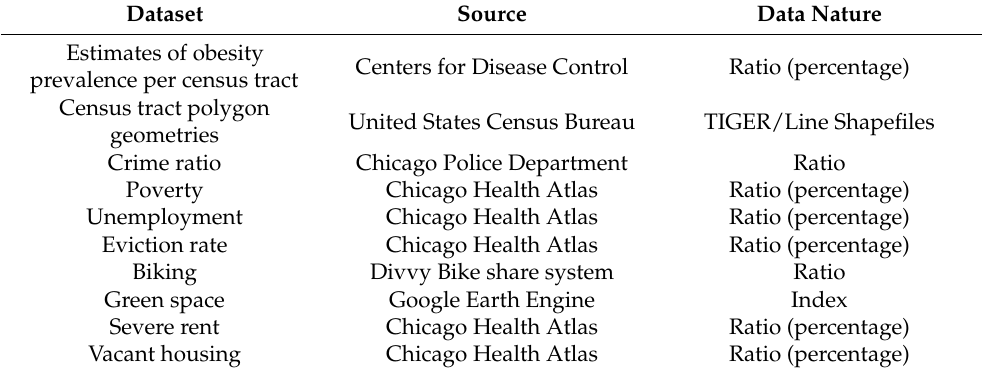
Table 1. Source and Nature of Data.